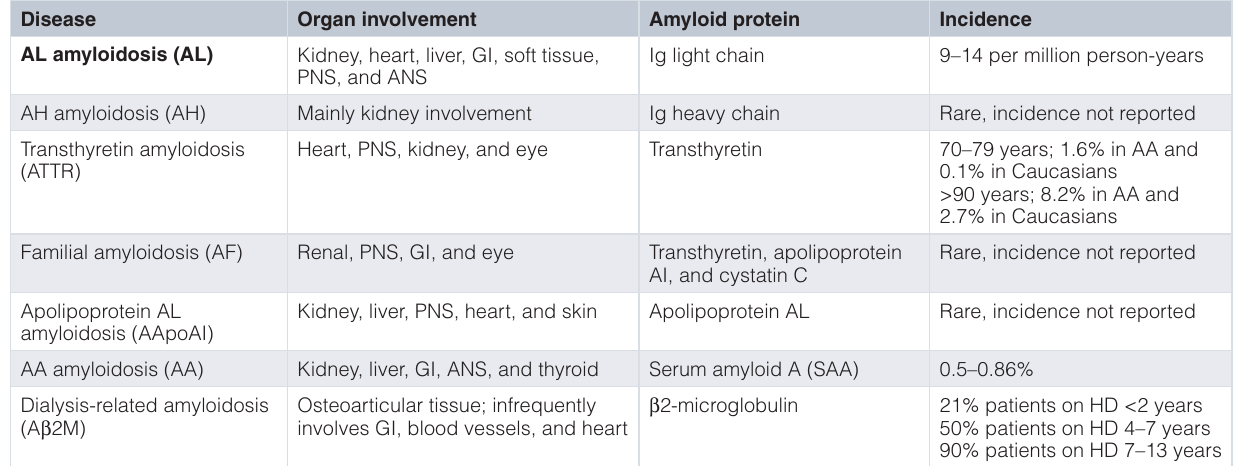
Table 1. Types of systemic